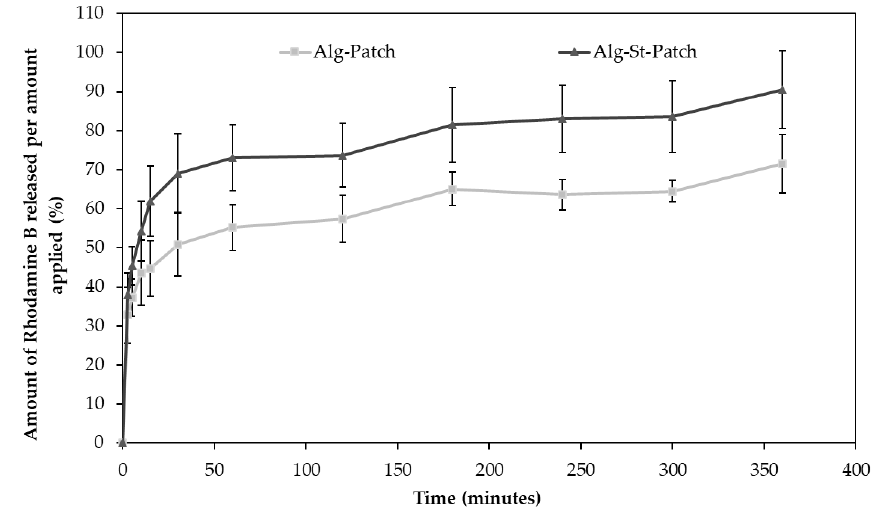
Figure 7. Release profiles of Rhodamine B from the Alg-patch and the Alg-St-patch (mean ± SD; n = 6).